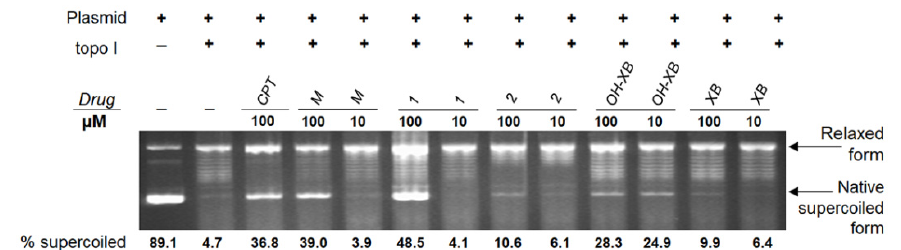
Figure 4. Inhibition of topoisomerase I. First, 250 ng plasmid DNA (pGEM1) was incubated with 10 µ M and 100 µ M of M , 1 , 2 , OH-XB and XB containing 2 µ L topo I. The percentage of supercoiled DNA was then determined by the ratio of supercoiled to relaxed DNA. The numbers below the bands give the mean fold increase of three independent experiments ( n = 3).